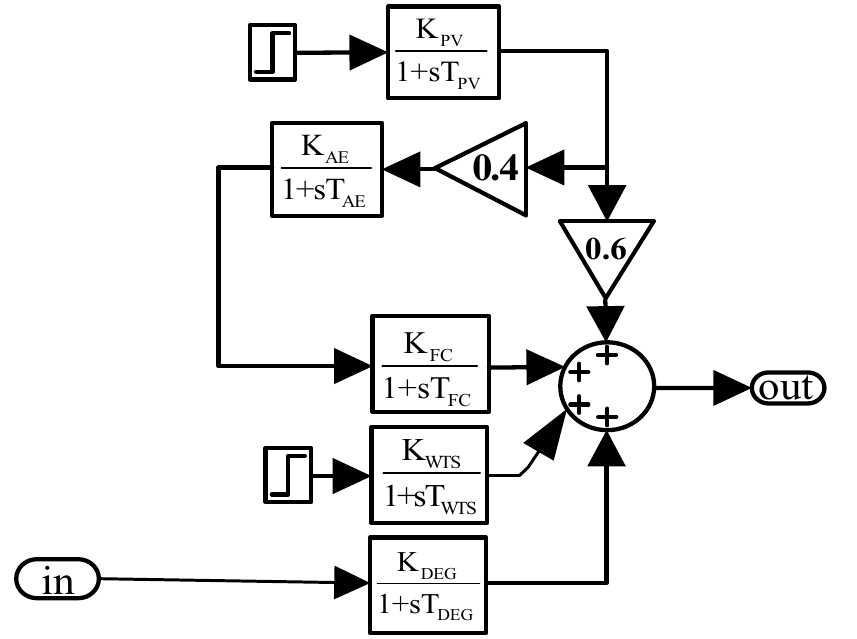
Figure 2. The distributed generators in area 1 of Figure 1.